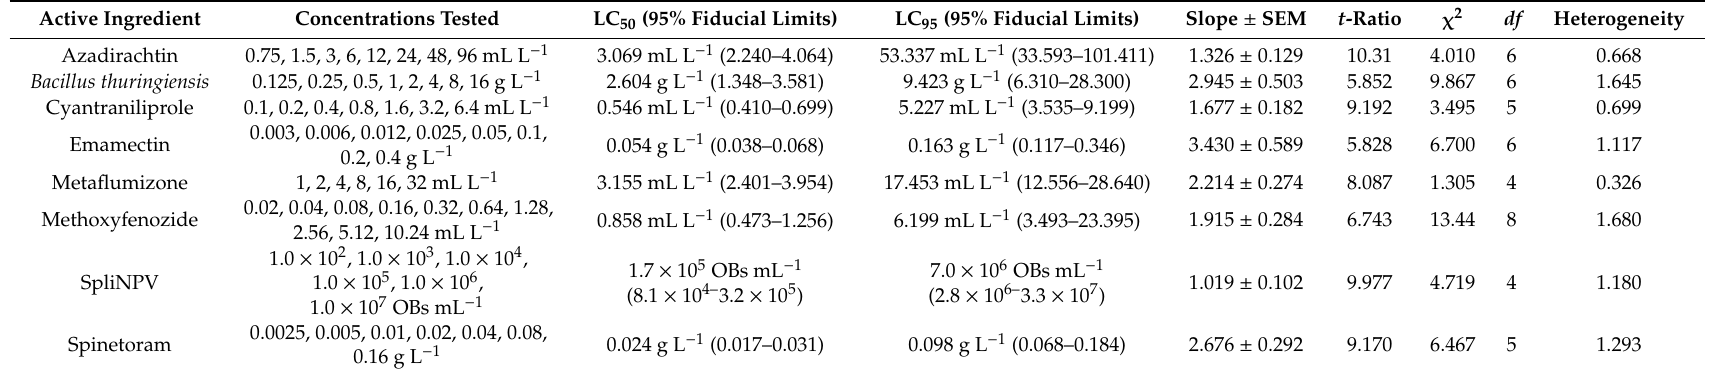
Table 3. Probit regressions of insecticides on Spodoptera littoralis second instar larvae, showing the concentrations tested, the LC 50 and LC 95 with upper and lower fiducial limits at 95%, slope ± SEM, t -ratio and statistics according to POLO-Plus program ( p ≤